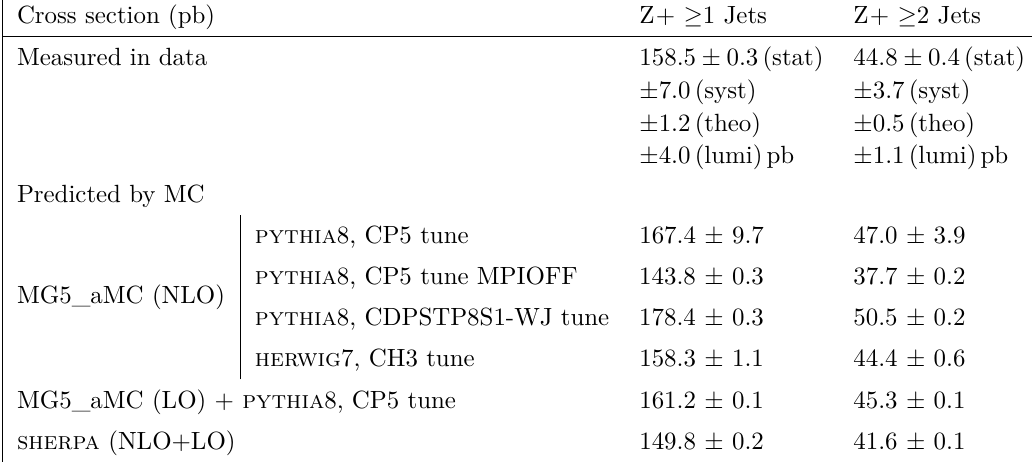
Table 5 . Measured and predicted cross section for Z + ≥ 1 jet and Z + ≥ 2 jet production. Sim- ulations are normalized to NNLO calculations (from fewz ) and reported cross section values are extracted by applying fiducial selections. Predicted cross sections include statistical and theoretical uncertainties added in quadrature for MG5_aMC + pythia 8 with CP5 tune, whereas the other predicted cross sections are reported with only statistical